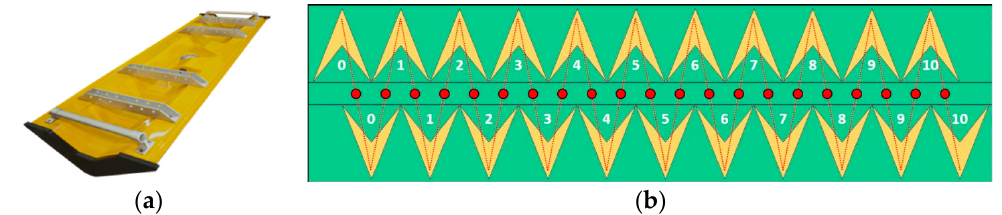
Figure 1. The step-frequency continuous wave Ground Penetrating Radar (SFCW GPR) equipment employed for the experimentation; ( a ) View of the array system; ( b ) Schematic sketch of the geometrical setup of the antenna array. The red dots represent the acquired GPR sample.